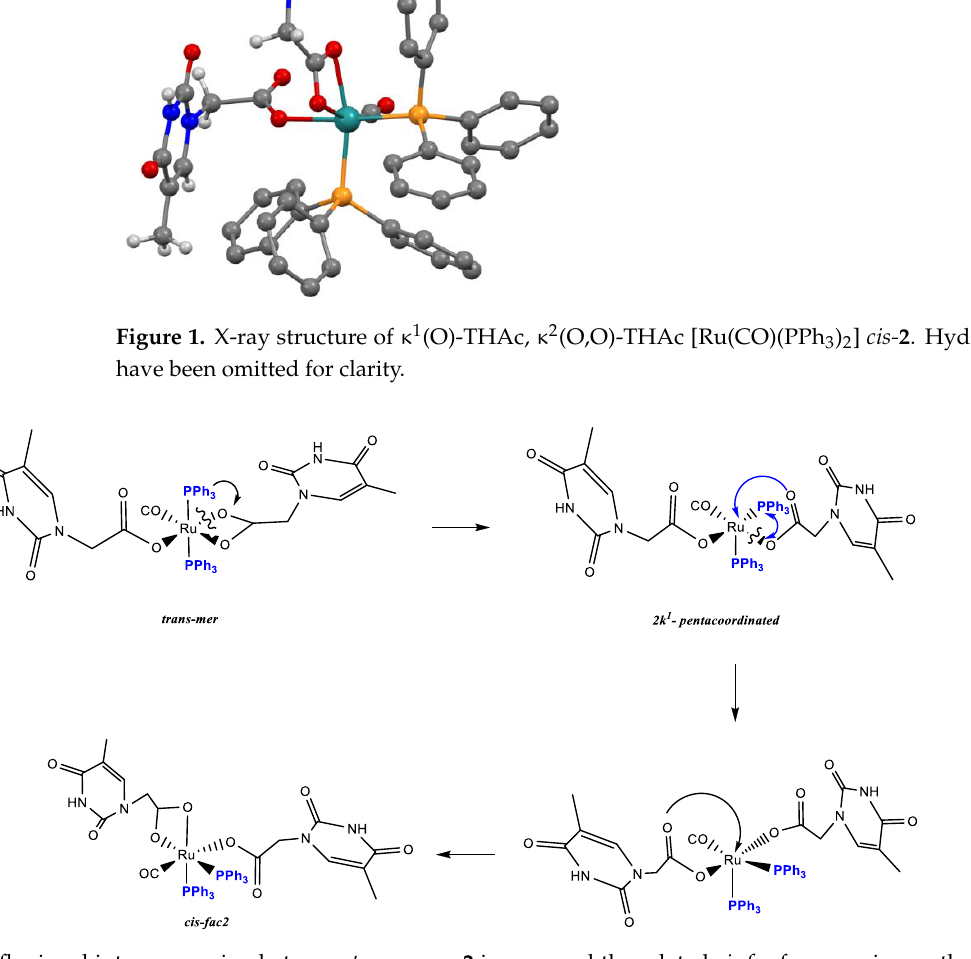
Figure 1. X-ray structure of κ 1 (O)-THAc, κ 2 (O,O)-THAc [Ru(CO)(PPh 3 ) 2 ] cis- 2 . Hydrogen atoms have been omitted for clarity. The cis P,P -fac THAc configuration in CDCl 3 is calculated to be almost isoenergetic and stabilized by a multi-intermolecular H-binding network, which is clear in the X-ray crystal packing. In the crystal environment, the κ 1 -THAc ligand is able to intermolecularly couple through Watson – Crick N-H ... O interactions with the chelate κ 2 (O,O)-THAc counterpart of the adjacent molecule, forming a supramolecular metallacycle, reinforced by antiparallel thymine ring π–π stacking together with a phosphine phenyl C-H ... O interaction [12]. In the crystal packing (Figure S2), symmetry related molecules of 2 are connected via two pairs of N-H ... O hydrogen bonds between κ 1 (O)THAc -and κ 2 (O,O)THAc ligands of neigh- boring molecules thus forming dimers centered about inversion centres. Further stabili- zation of the dimer is achieved by π–π stacking of the thymine rings (centroid-centroid